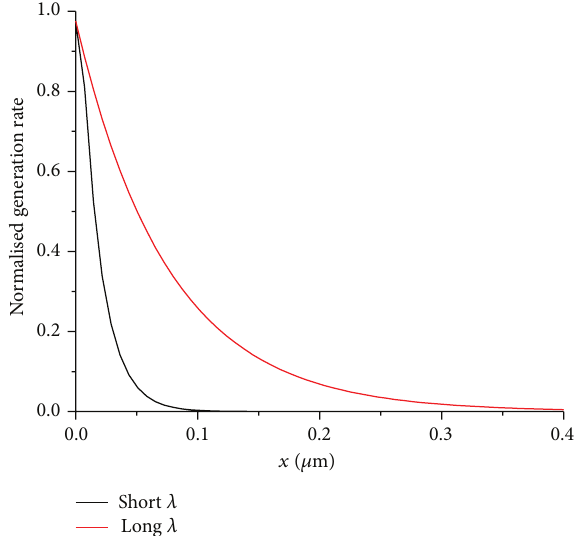
Figure 7: Photon generation rate as a function of surface distance.